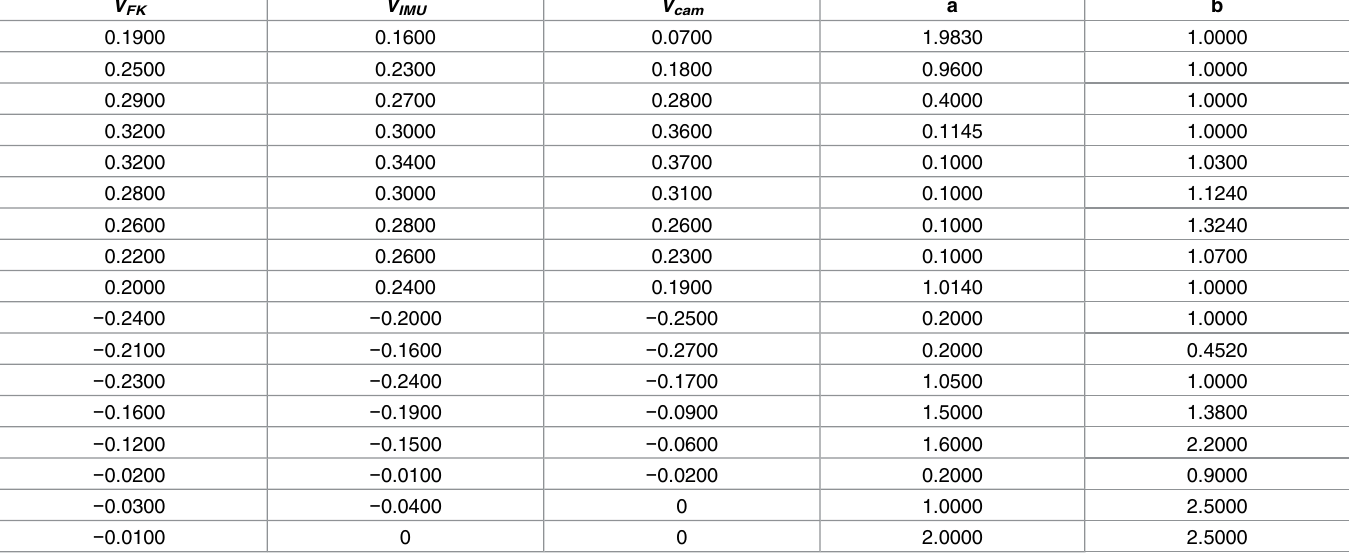
Table 4. The platform